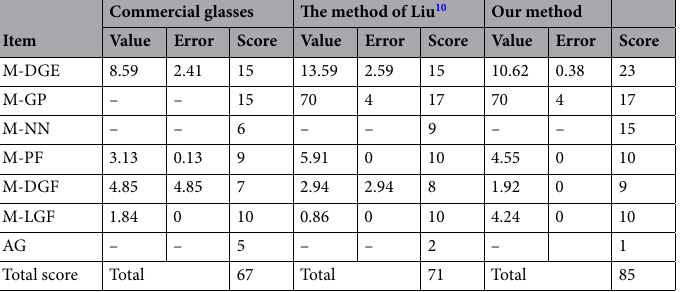
Table 7. GFS of example 3 with the commercial glasses, the Liu 10 method, and our method.